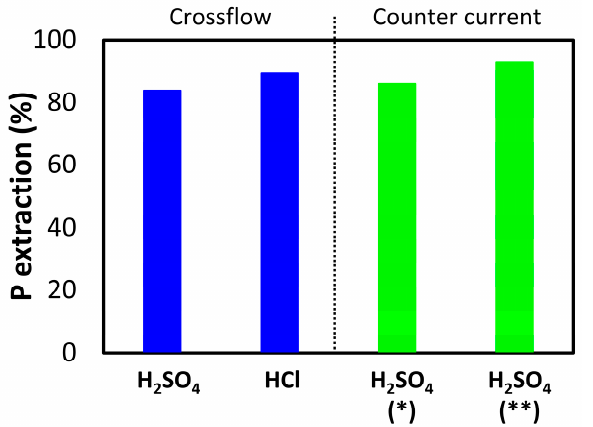
Figure 3. Percentages of P recovery with the different extraction procedures (extraction time: 4 h).